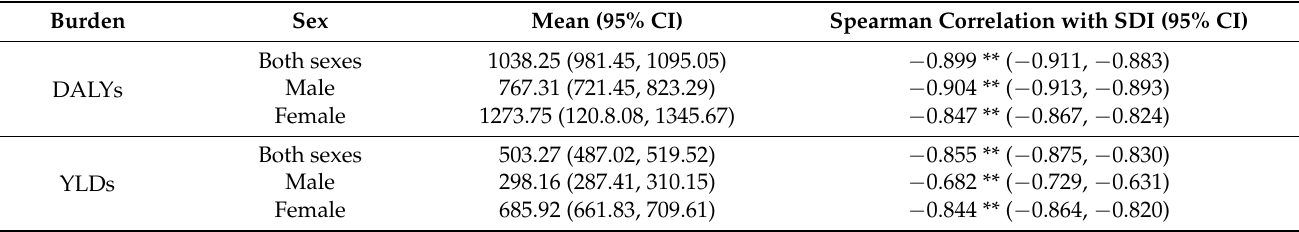
Table 3. Associations of age-standardized DALYs and YLDs attributable to nutritional deficiency with sex and SDI among older adults (65+) from 1990 to 2019 in the Western Pacific